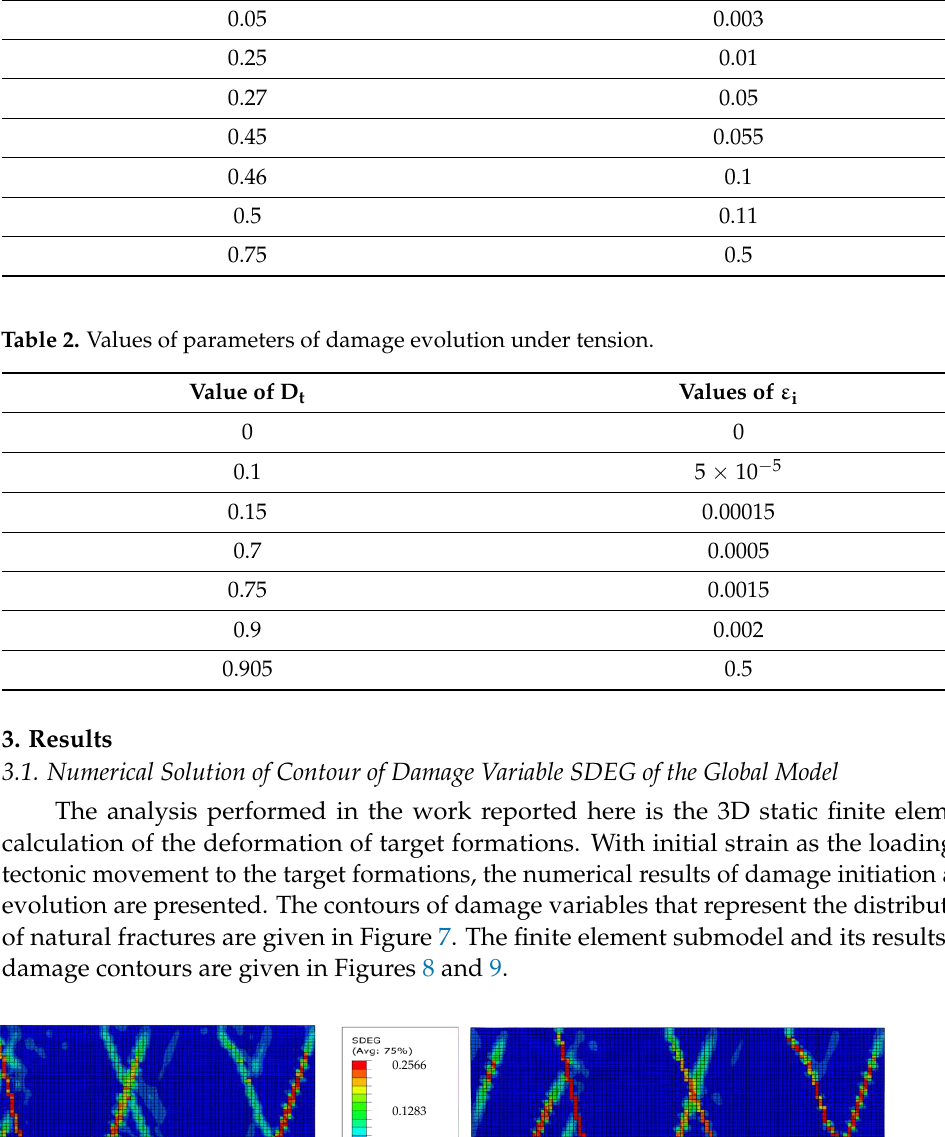
Table 2. Values of parameters of damage evolution under tension.